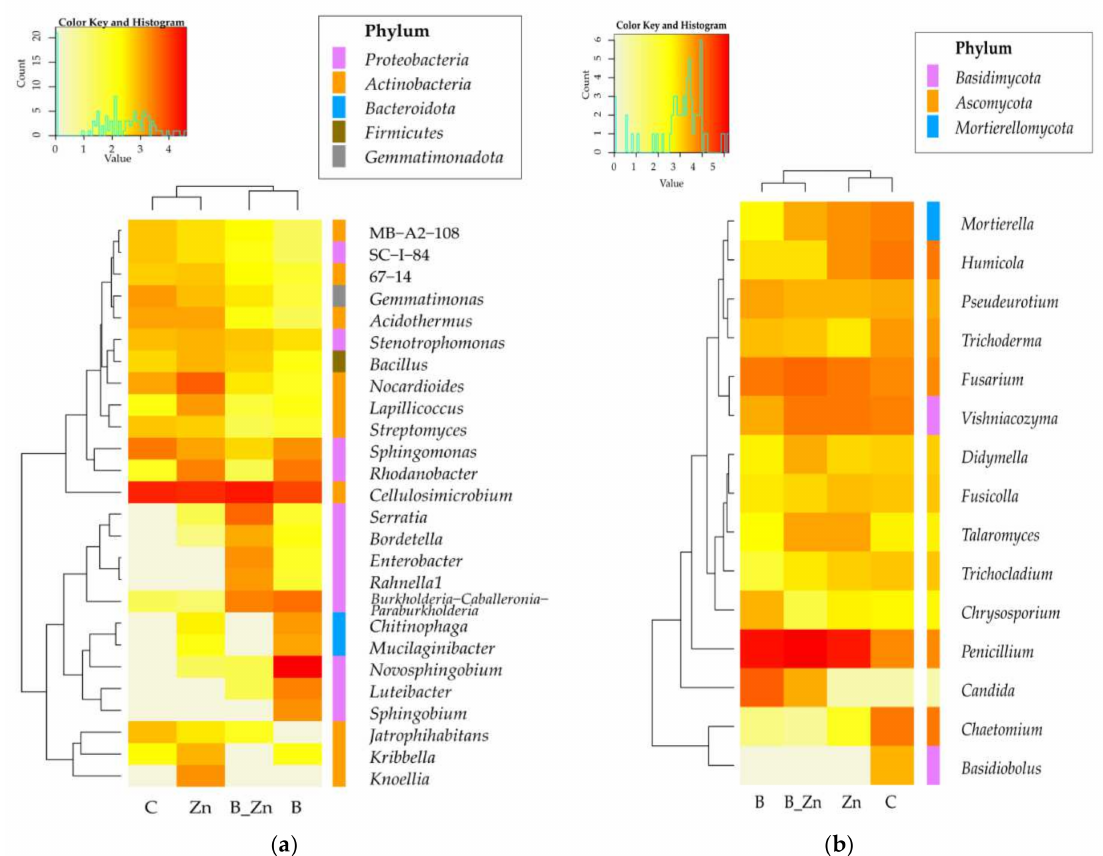
Figure 10. Heat map of the dominant genus types of ( a ) bacteria and ( b ) fungi in the soil. Data in the figures are represented by decimal logarithms, with a difference between proportions ≥ 1%; C—uncontaminated soil; B—bisphenol A; Zn—ion zinc (Zn 2+ ).